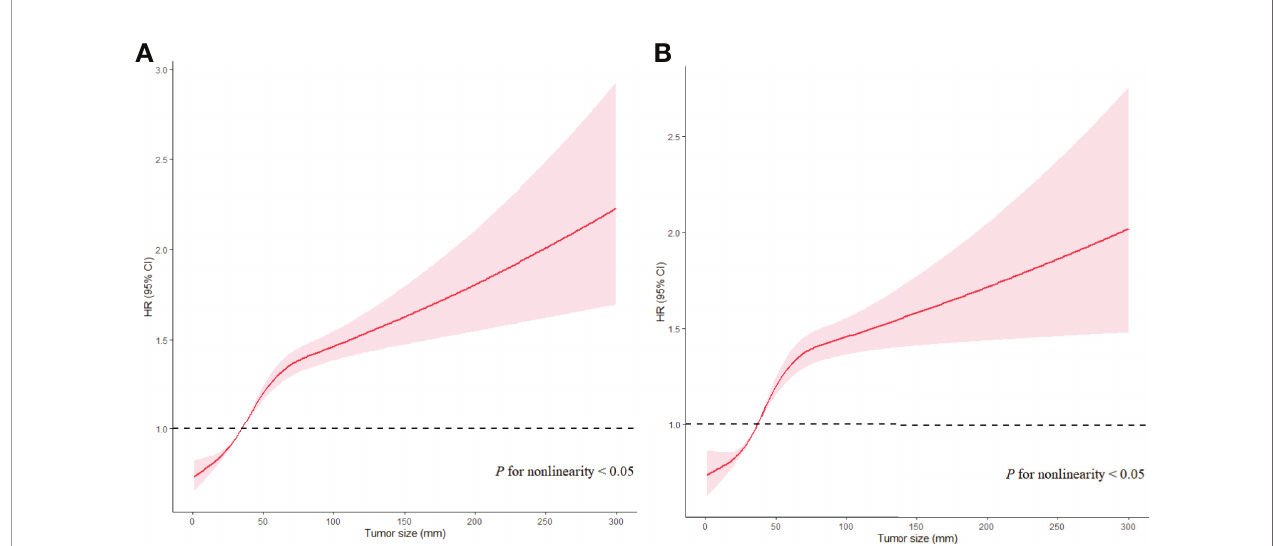
FIGURE 2 | Associations of Ts with prognosis in EC patients in Cox models with RCS after adjustment. Red lines estimated HR of Ts; shadow area 95% CI. (A) Adjusted RCS model for ACD. (B) Adjusted RCS model for ESD.